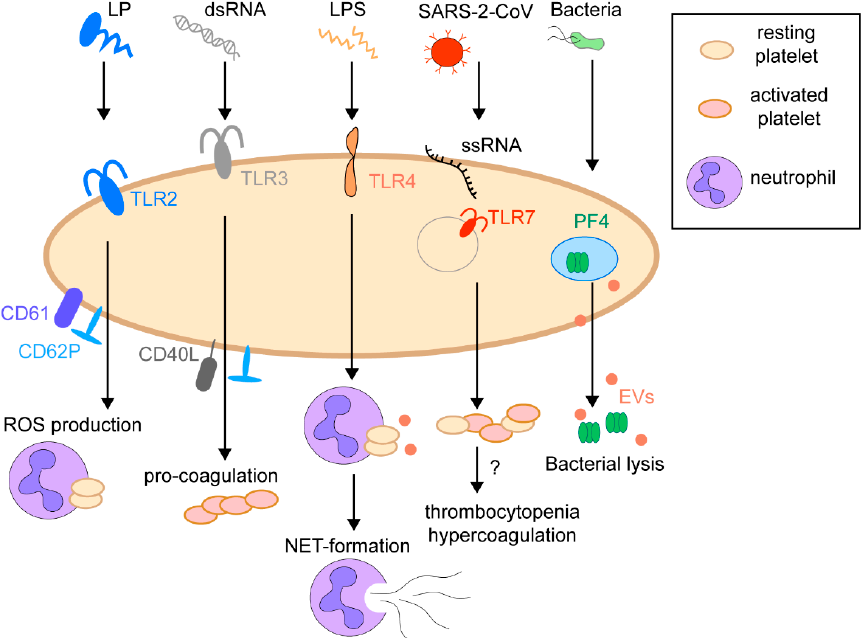
Figure 3. The immunoregulatory function of platelets. Platelets possess a set of pattern recognition receptors (PRRs) sensing pathogen-associated molecular patterns (PAMPs), such as lipoproteins (LP), lipopolysaccharides (LPS), nucleic acids, including double-strand RNA (dsRNA) and single-strand RNA (ssRNA).